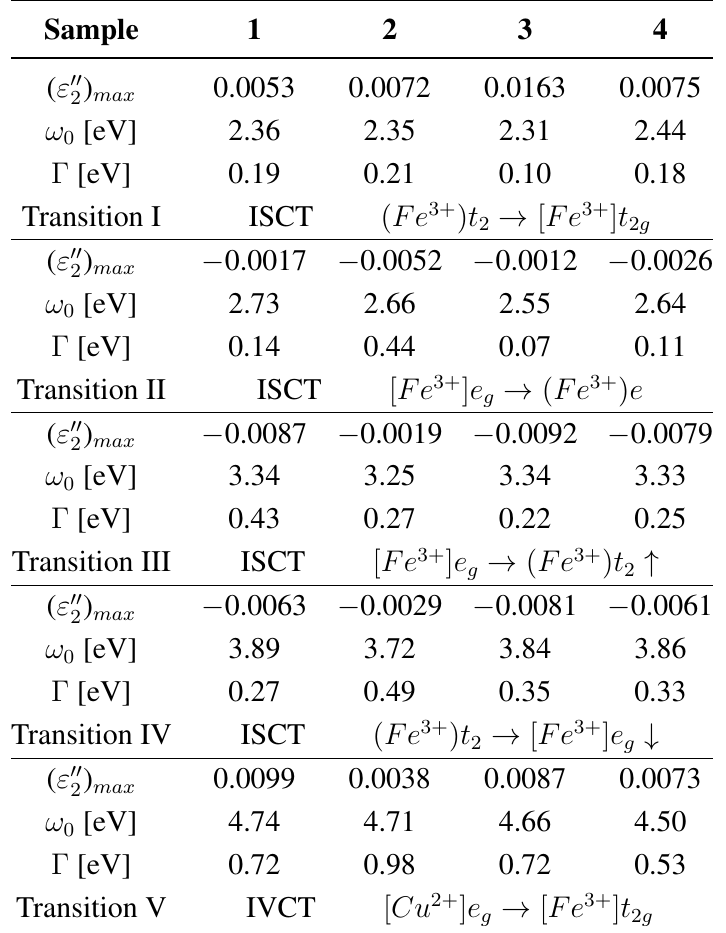
Table 2. The magneto-optically active transitions in CuFe and 5.0